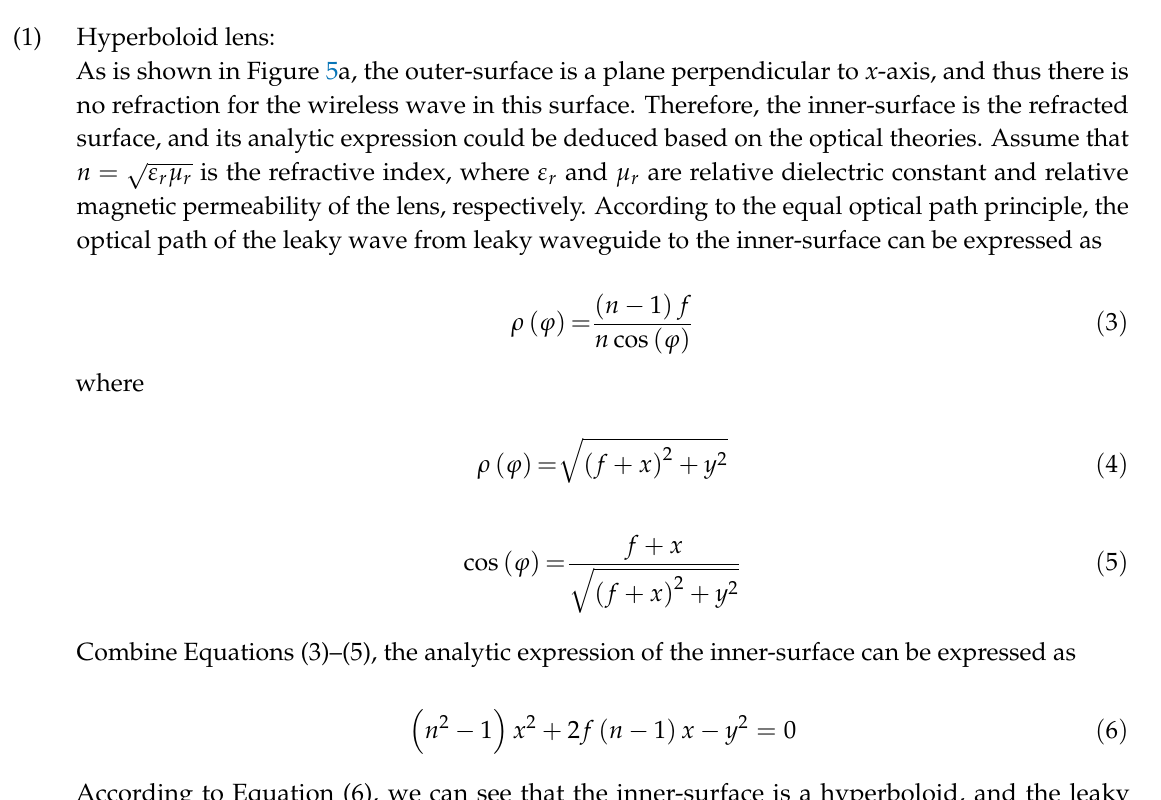
Figure 5. Two types of leaky lens: ( a ) Hyperboloid lens and ( b ) ellipsoid